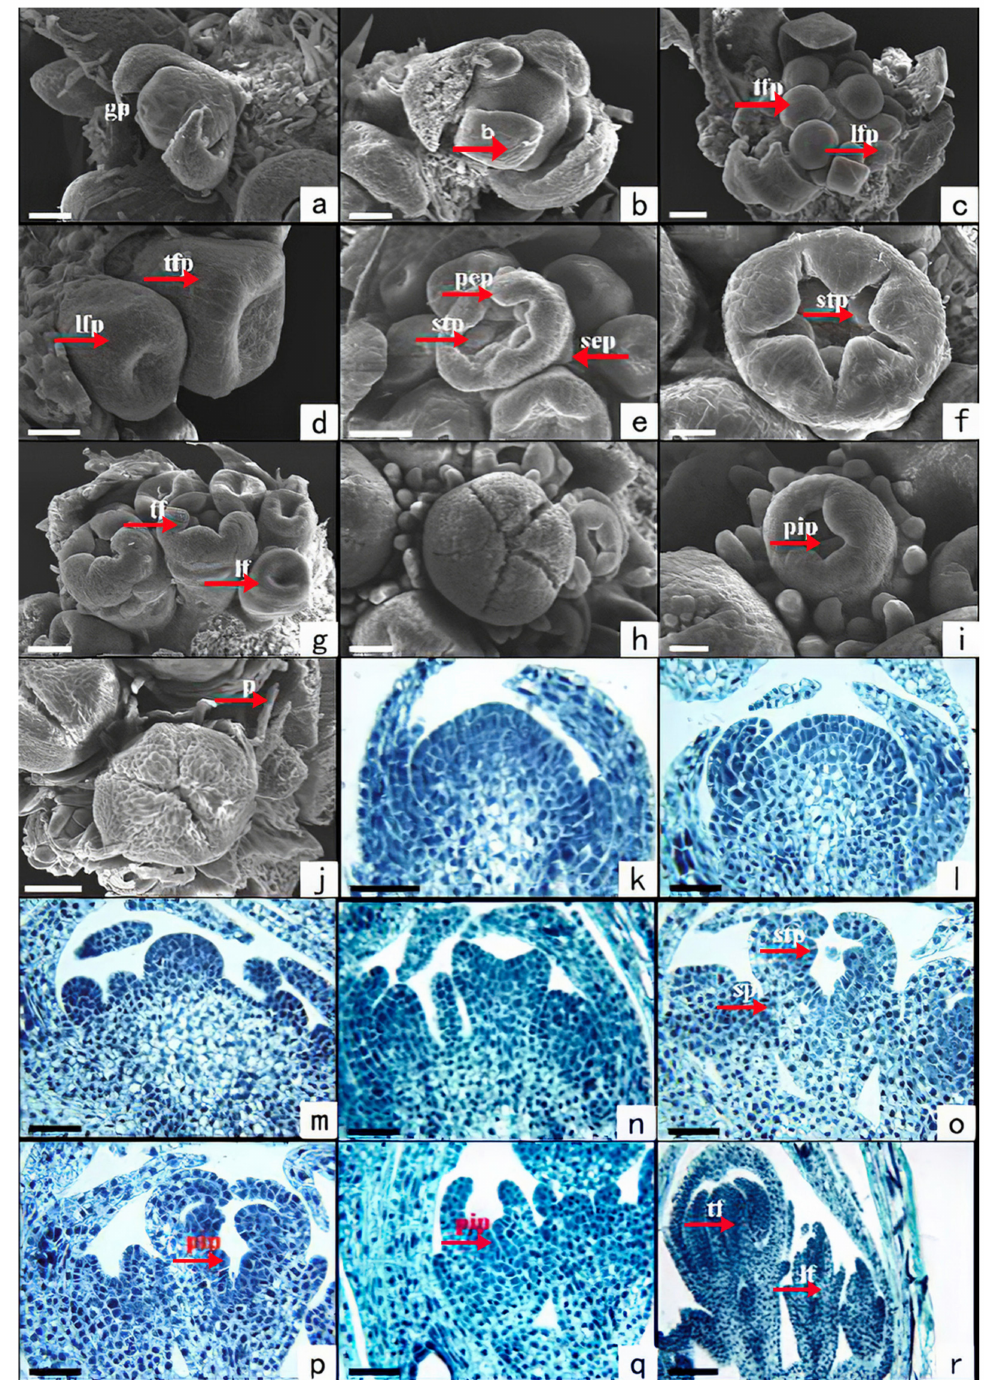
Figure 2. Capitulum development of S. canadensis (population number: CN04). Observed and photographed by scanning electron microscopy ( a – j ) and optical microscope ( k – r ). ( a , k ) The pre- differentiation stage. ( b , l ) The periclinium differentiation stage. ( c , m ) The floret primordia differen- tiation stage. ( d , n ) The corolla primordium differentiation stage. ( e , o ) Differentiation of the calyx and the stamen primordium. ( f ) Stamen primordia enlarge. ( g ) The second sepals of the tubular flower and the sepals of the ligulate flower form. ( h , p ) Closed corolla of a tubular flower and stamen differentiation. ( i , q ) Stamen differentiation of a ligulate flower. ( j , r ) End of the differentiation. Scale bars: a–c = 50 µ m, d =25 µ m, e = 50 µ m, f = 25 µ m, g–h = 50 µ m, i = 25 µ m, j = 100 µ m, k–q = 50 µ m, r = 100 µ m. gp, Growing point; b, bract; tfp, tubular flower primordium; lfp, ligulate flower pri- mordium; pep, petal primordium; stp, stamen primordium; sep, sepal primordium; pip, pistil primordium; p, pappus; tf, tubular flower; lf, ligulate